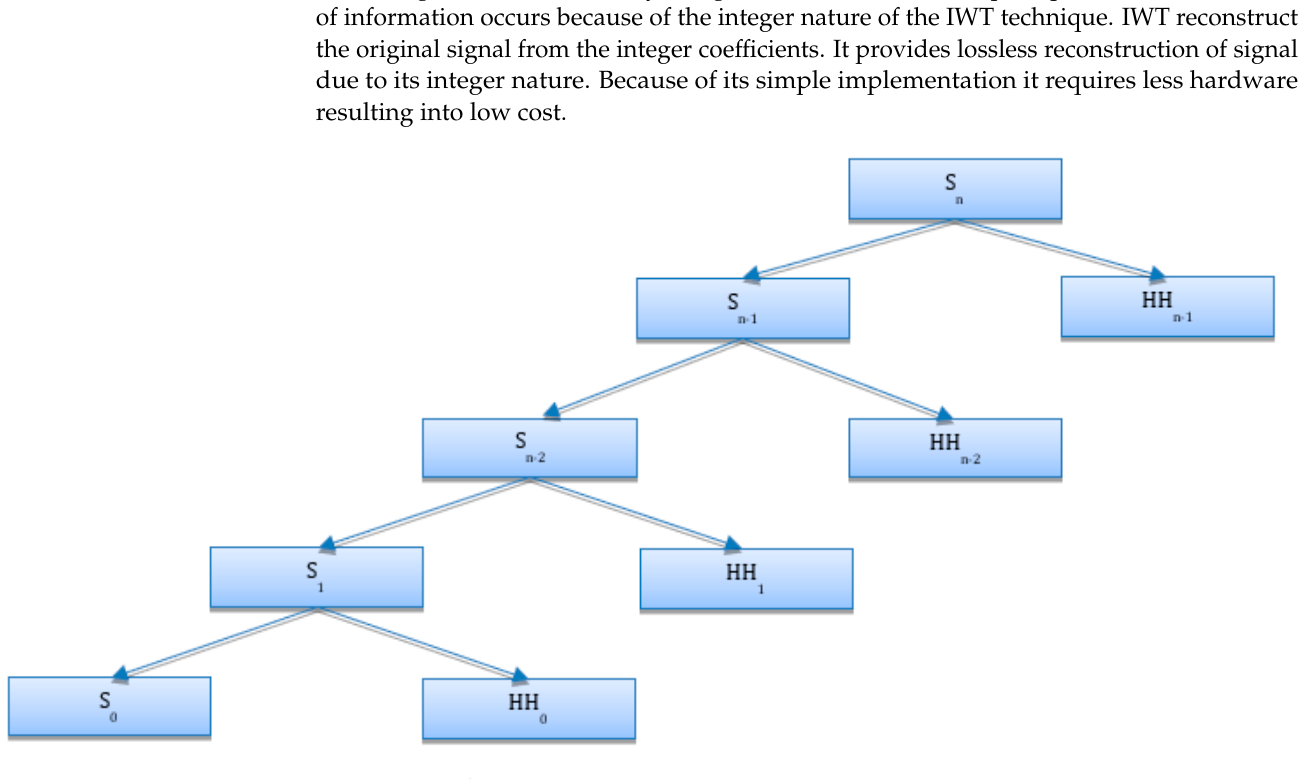
Figure 7. Signal Reconstruction.